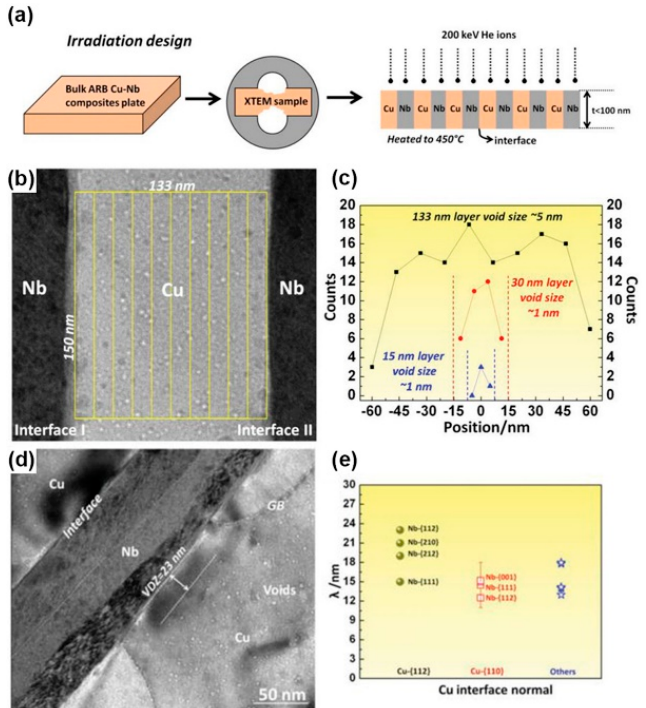
Figure 5. ( a ) Schematic illustration of the He ion irradiation experimental procedures. ( b ) Illustration of the method to determine the void number density in Cu layers. ( c ) Plot of the number density of voids as a function of distance from the center of the layer in 133 nm-, 30 nm- and 15 nm-thick Cu layers. ( d ) Under-focus TEM image showing a void-denuded zone (VDZ) near a Cu / Nb interface. ( e ) Widths of VDZs near Cu / Nb interfaces sorted by their plane orientations [31].